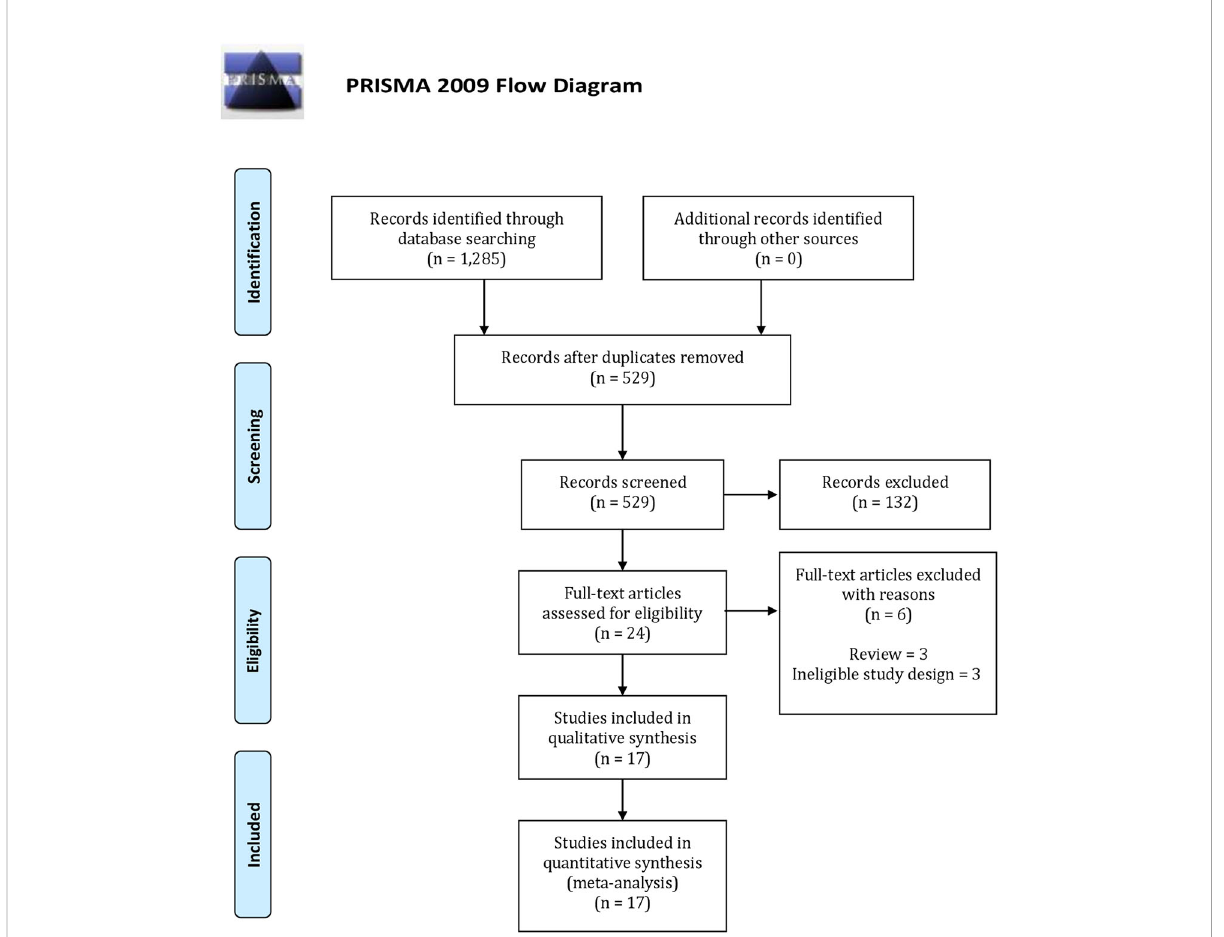
FIGURE 1 Preferred reporting items for systematic reviews and meta-analyses based search strategy fl ow